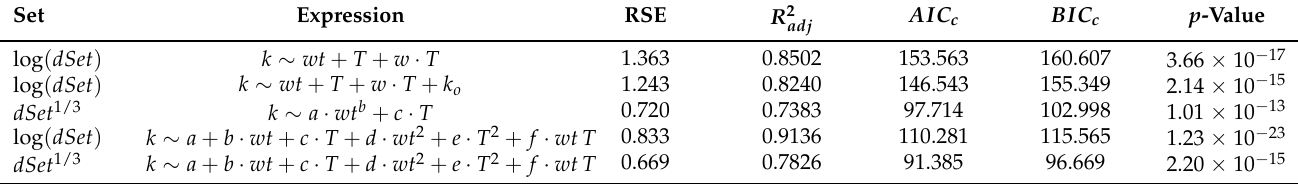
Table 11. Regression results for k as a function of wt and T for the XG